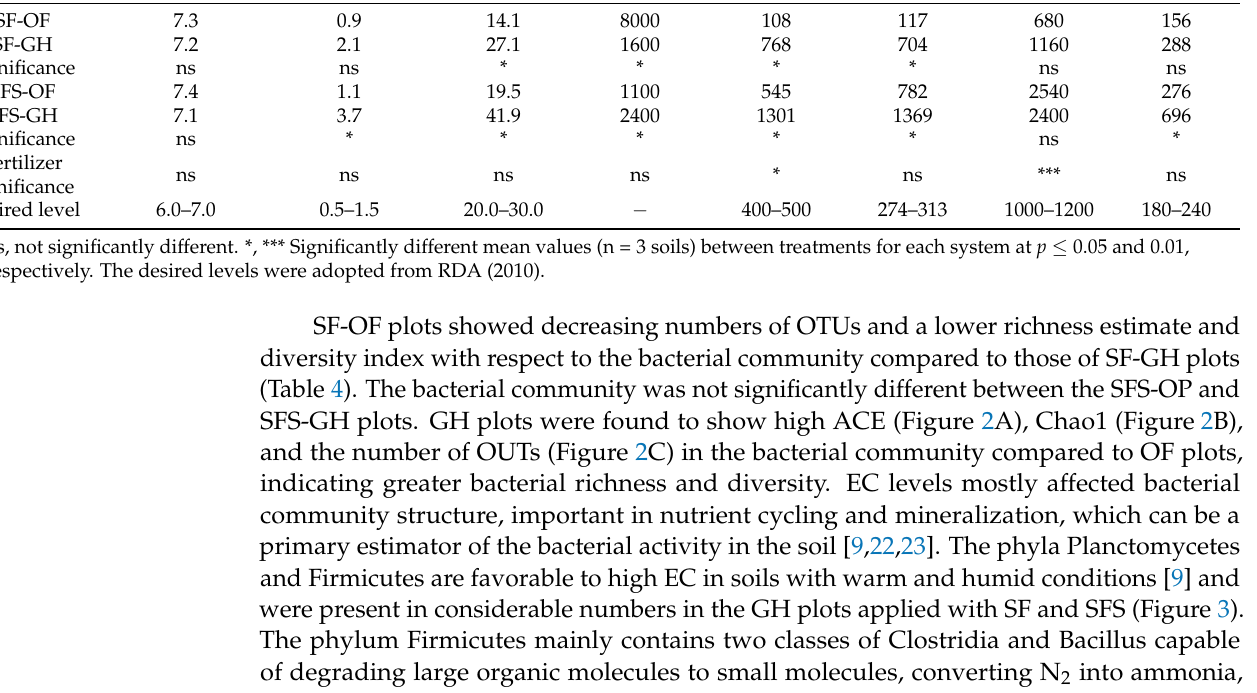
Table 3. Soil mineral nutrients as affected by starfish (SF)- and starfish + seaweed (SFS)-liquid fertilizers applied in open-field (OF) and greenhouse (GH) cultivated red peppers. Treatment